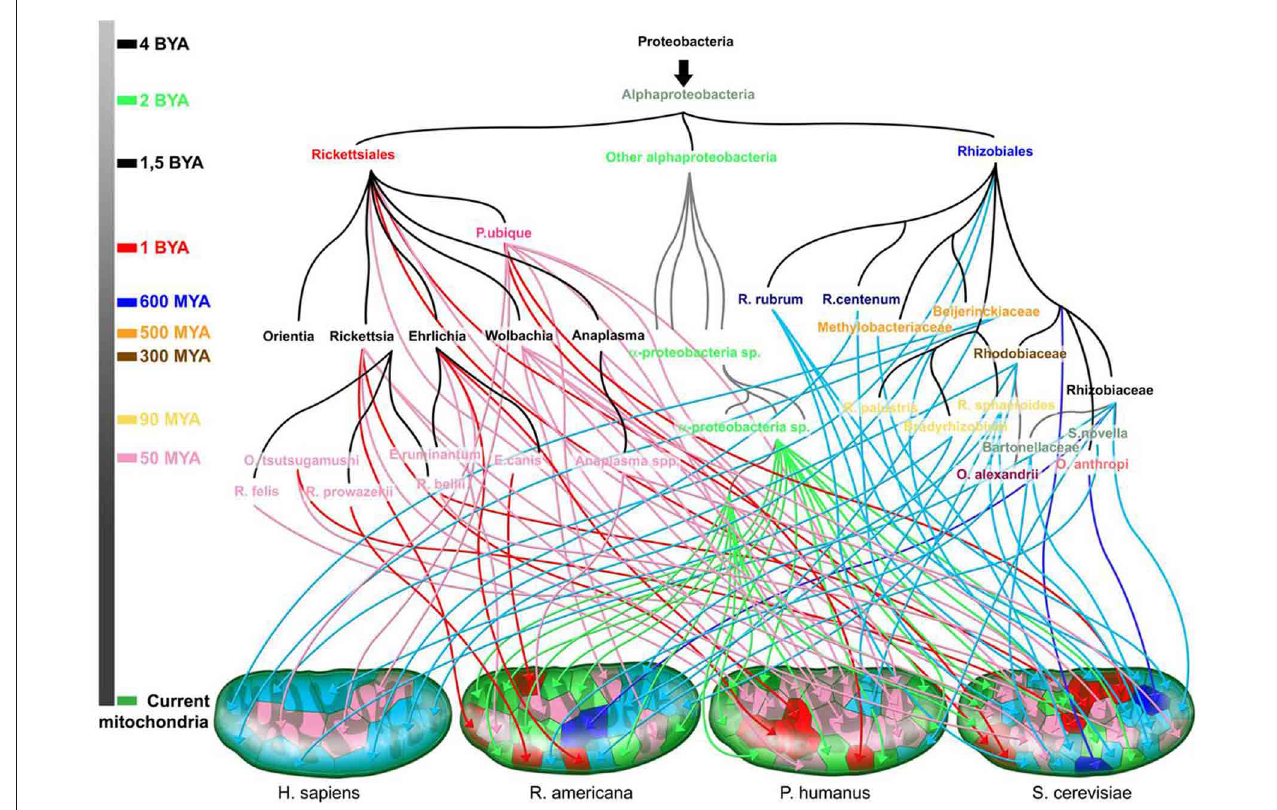
FIGURE 8 | The rhizome of mitochondria (adapted from Georgiades and Raoult (2011). The origin of each gene is represented along with the time scale of the species divergence. Dark blue and red arrows are for sister taxa with high bootstrap values, and light blue and pink